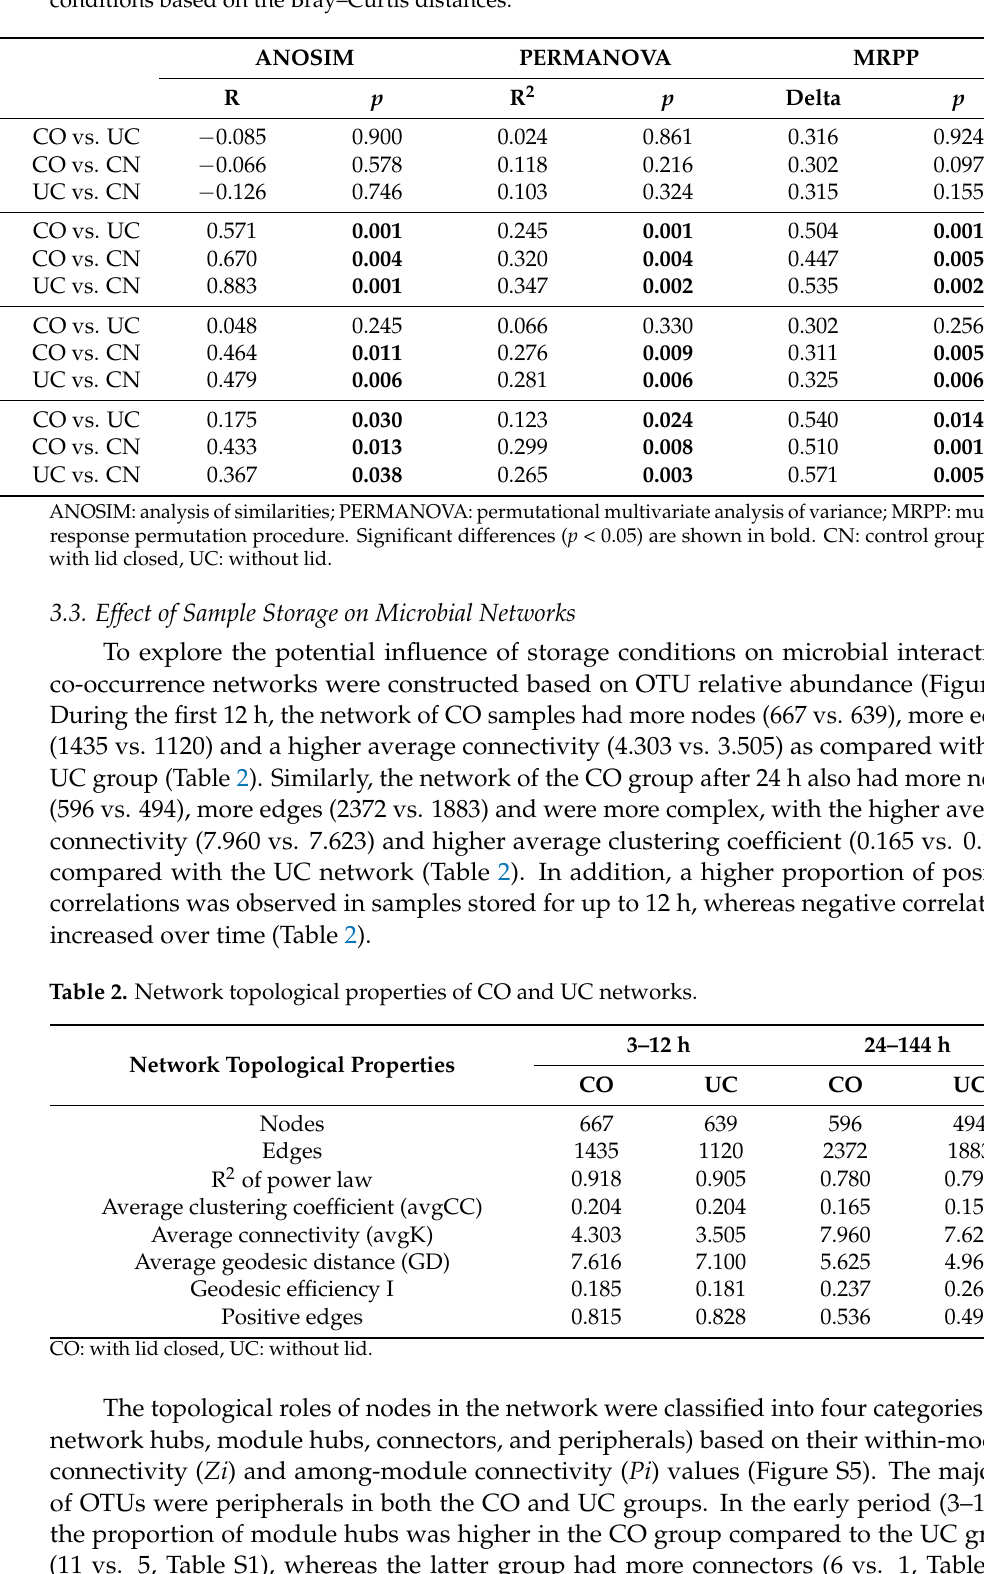
Table 1. Dissimilarity tests showing the differences of microbial communities under different storage conditions based on the Bray–Curtis distances.